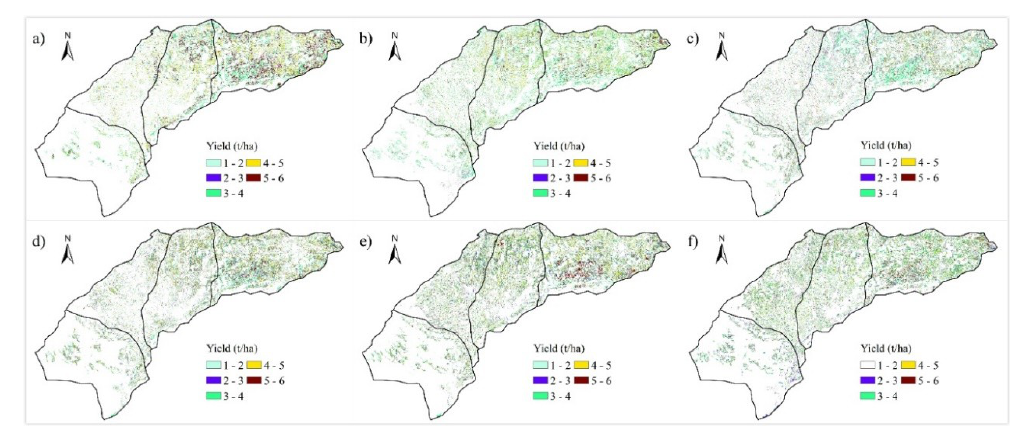
Figure 9. Sunflower yield maps from 2010 to 2015 ( a – f ).